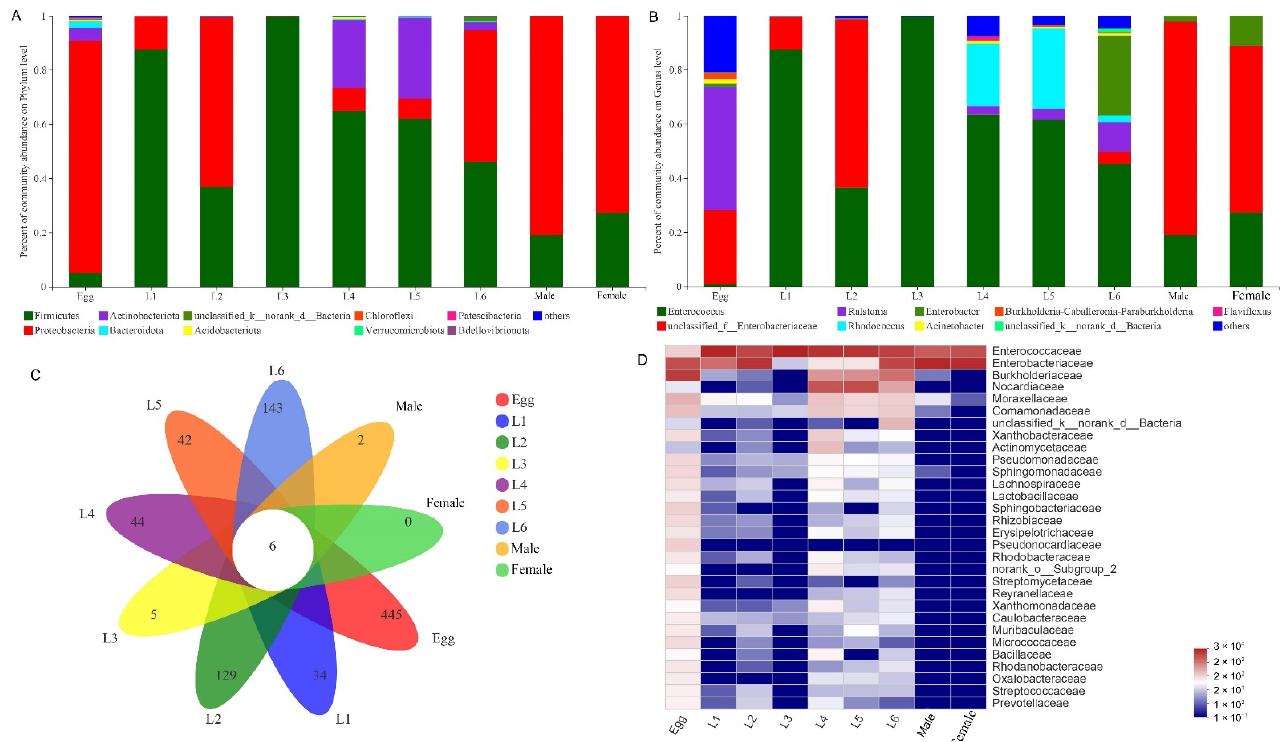
Figure 1. Gut bacterial community dynamics in different developmental life stages of S. frugiperda . ( A ) Gut bacteria composition at the phylum level; ( B ) Gut bacteria composition at the genus level; ( C ) Venn plot of OTUs in different developmental life stages; ( D ) Heatmap of the top 30 abundant families showing the relative abundance of the bacteria taxa assigned to a family level.